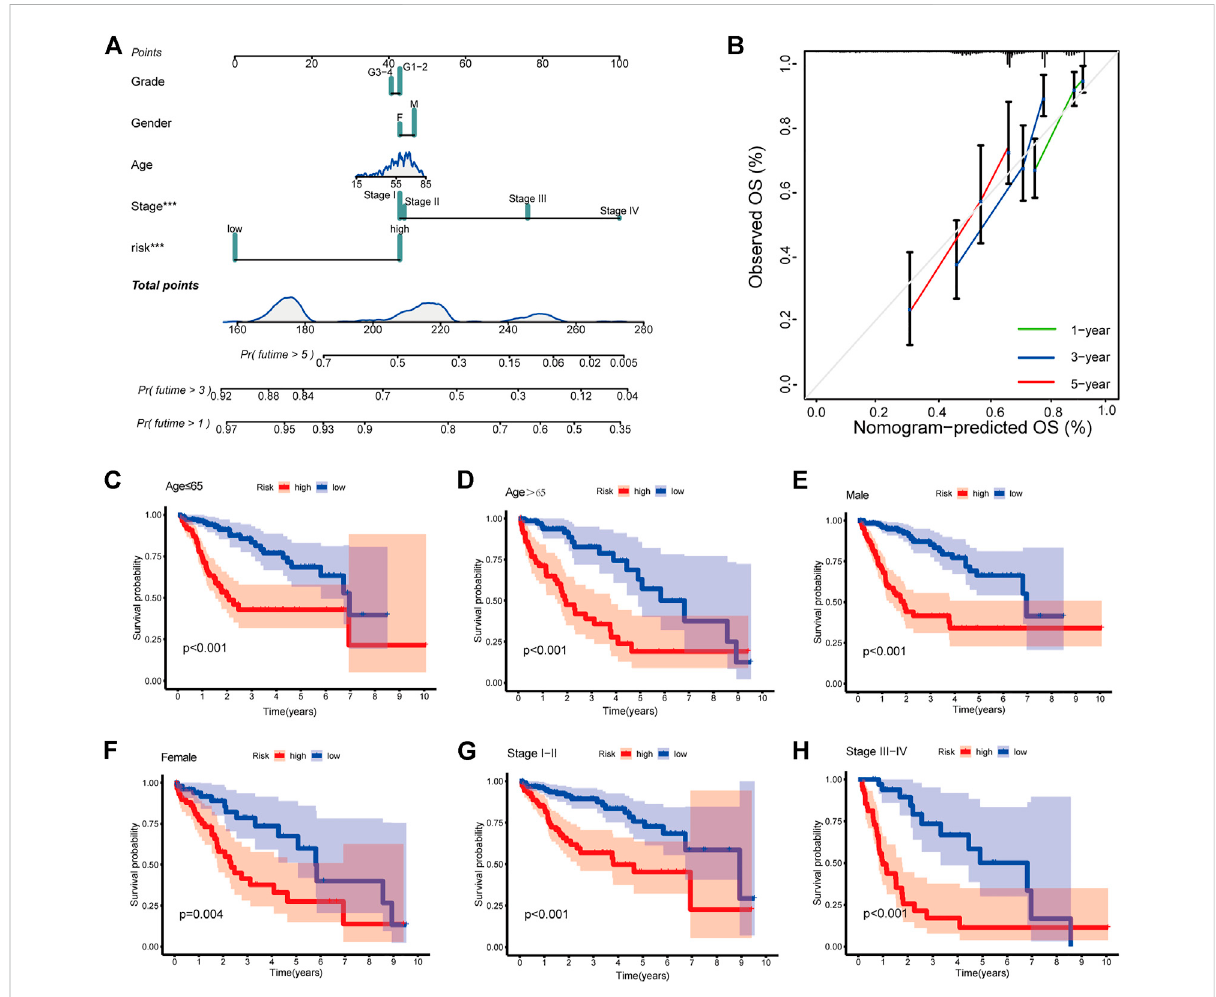
FIGURE 4 Clinical prognostic nomogram for survival prediction and subgroup analysis (A) A nomogram combining clinicopathological variables and risk scorepredicts1,3,and5yearsOSofHCCpatients. (B) Calibrationplotsfor1-,3-,and5-yearssurvivalpredictions (C – H) Subgroupsurvivalanalysisin the high- and low-risk groups, (C) Age ≤ 65 (D) Age > 65 (E) Male patients (F) Female patients (G) Stage Ⅰ - Ⅱ (H) Stage Ⅲ - Ⅳ